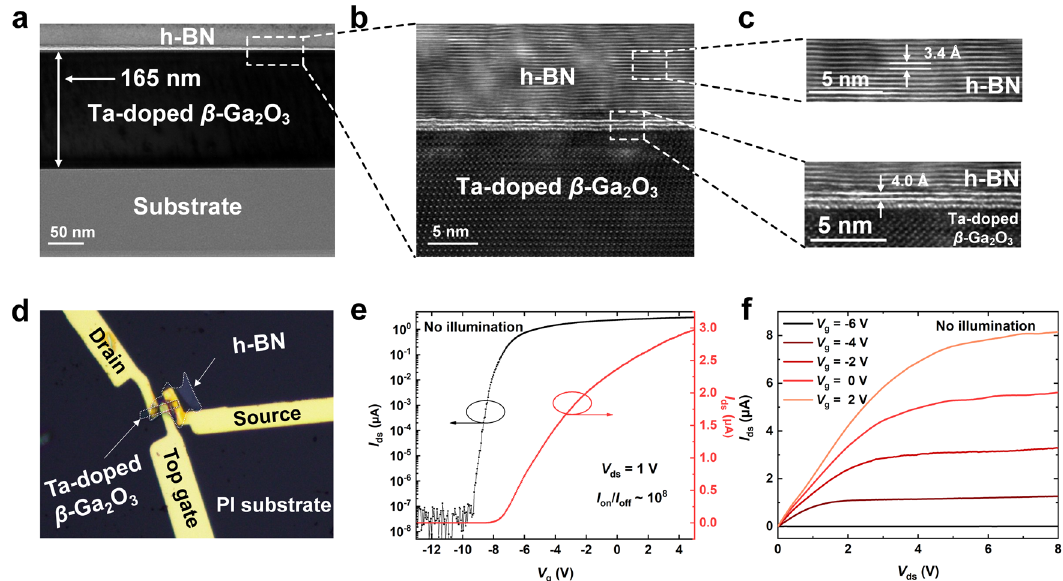
Fig. 2 Interface analysis and electrical properties of the Ta-doped β -Ga 2 O 3 transistor. a Cross-sectional HR-TEM image of the stacked Ta-doped β -Ga 2 O 3 /h-BN heterostructure on SiO 2 /Si substrate. b High-magni fi cation HR-TEM image of an enlarged area for the interface of Ta-doped β -Ga 2 O 3 /h-BN heterostructure. c Top image: High-magni fi cation cross-sectional HR-TEM image of the h-BN fl ake. Bottom image: high-magni fi cation cross-sectional HR-TEM image of the interface of Ta-doped β -Ga 2 O 3 /h-BN heterostructure. d The optical microscopic image of the fabricated β -Ga 2 O 3 transistor. e The transfer curves ( I ds - V g ) of the fabricated β -Ga 2 O 3 transistor in log and linear scales under dark condition at V ds = 1 V. f The output curves ( I ds - V ds ) of the fabricated β -Ga 2 O 3